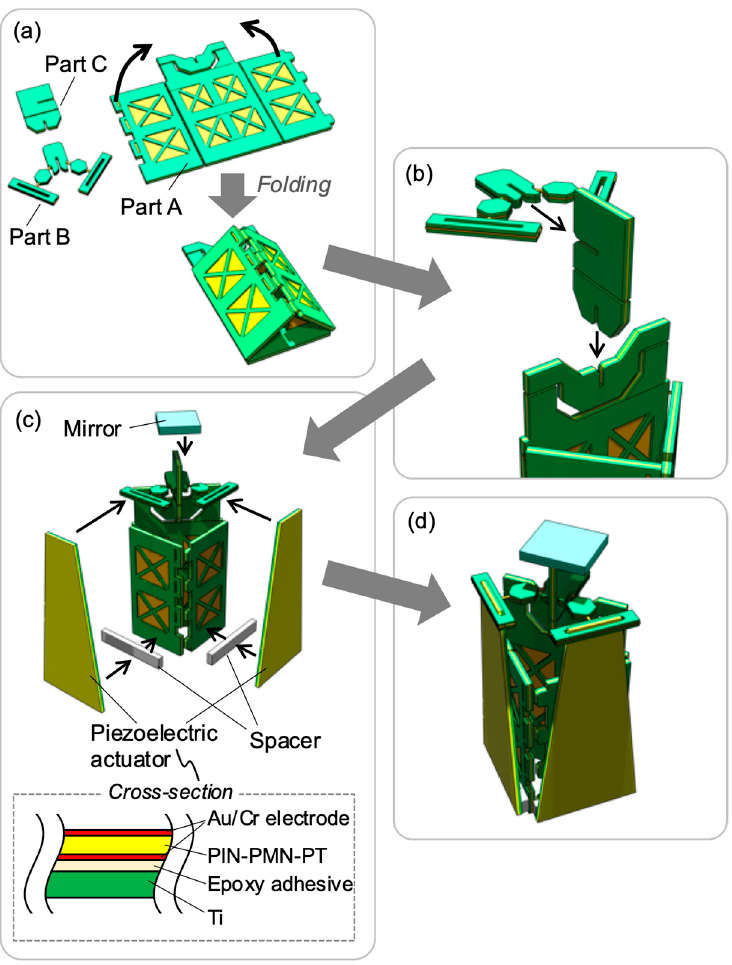
Figure 9. Assembly procedure of 2-DoF actuation mechanism: ( a ) origami assembly of Part A; ( b ) 2-DoF hinge assembly; ( c ) attachment of mirror and piezoelectric actuators; ( d ) completed device.